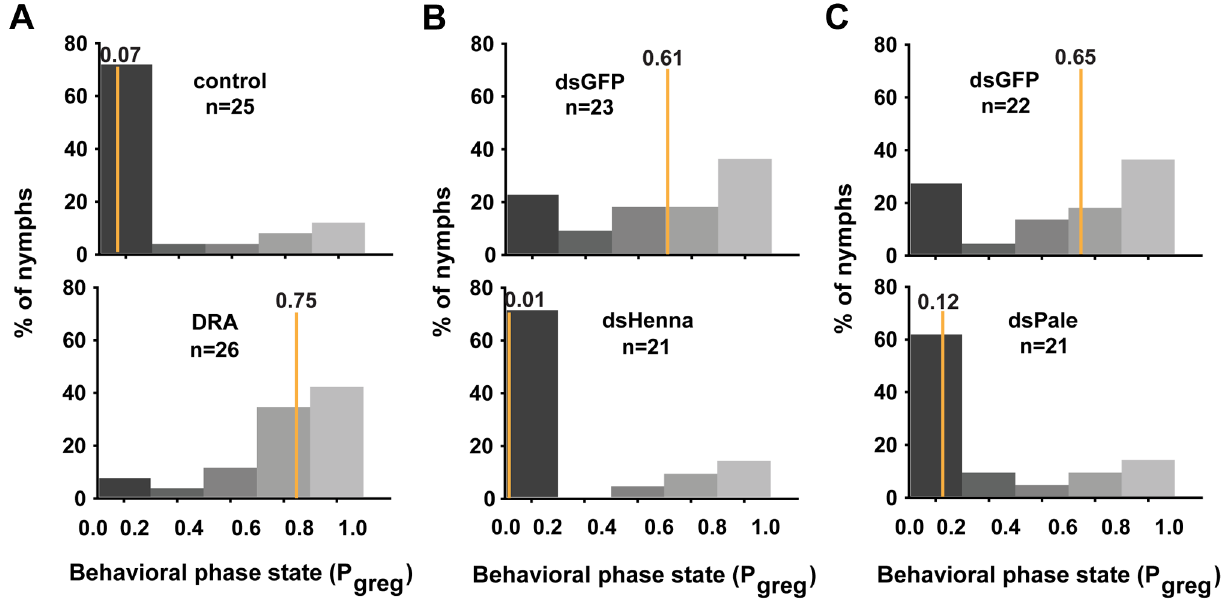
Figure 6. The dopamine pathway is the direct effector for mediating the miR-133-regulated behavioral transition. (A) The behavioral rescue experiment in gregarious locusts was performed by increasing the dopamine content through injection with the dopamine receptor agonist (DRA), R -(-)-apomorphine, or a saline control in locusts pre-treated with agomir-133. (B, C) The behavioral rescue experiment in solitary locusts was performed by injecting dsRNA against henna / pale into the locusts pre-treated with antagomir-133. P greg , probabilistic metric of gregariousness. The vertical lines indicate the median P greg values. P greg =1 indicates fully gregarious behavior, and P greg =0 indicates fully solitary behavior.